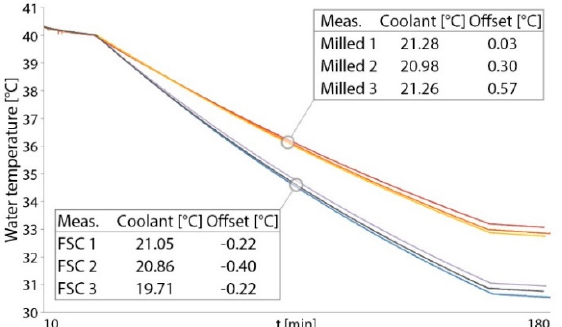
Figure 11. Calorimeter water temperature for six experiments. Coolant average temperature varies slightly with the ambient temperature. Offset is used for the lines to set 40 °C as an initial temperature for the moment when the coolant flow is started. Coolant flow is 50 L/min (20 °C, 101 kPa). Calorimeter heat loss can be seen in flat curves before and after the coolant flow has been started. These values can be used to determine calorimeter loss. Adapted from [35].